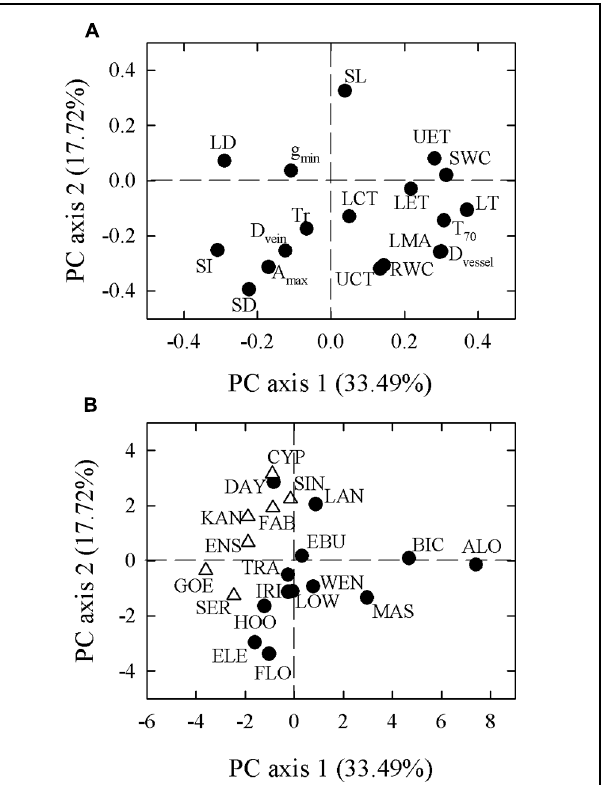
FIGURE 2 | Principal component analysis (PCA) based on species trait values (A) for 18 leaf functional traits in 20 Cymbidium species. Loadings of terrestrial (open triangle) and epiphytic (filled circle) species along PCA axes are presented in (B) . Values in parentheses along each axis indicate percentage of explained variation. Abbreviations for traits and species are defined in Table 1 and Supplementary Table S1,